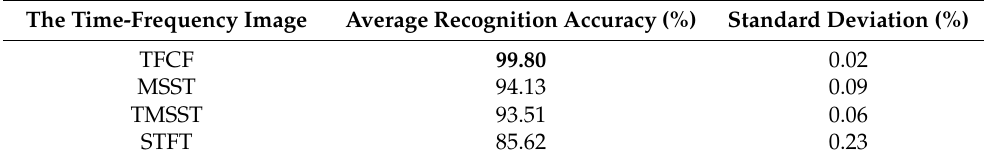
Figure 5. Training of RTFANet model under different inputs: ( a ) curve of training set loss; ( b ) curve of the accuracy of the test set. Table 3. RTFANet recognition results of different time frequency images